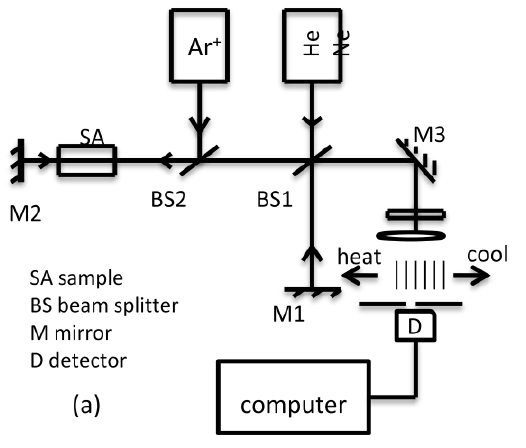
Figure 11. Ar + laser heats the sample. A HeNe laser was used to setup a Michelson interferometer configuration to measure laser heating of Pr 3+ -doped YAG crystal